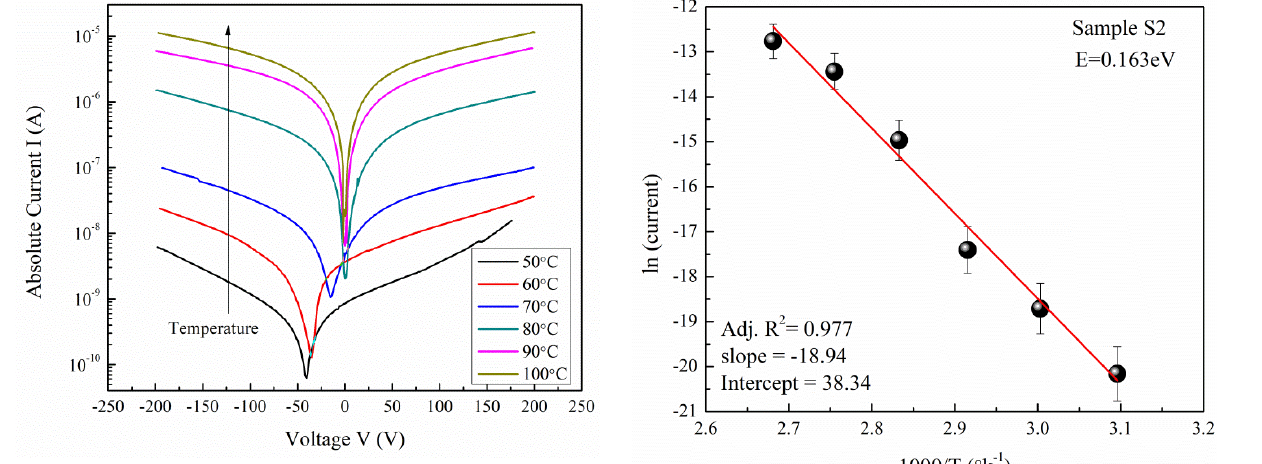
erties [40–43]. This butterfly shape is produced due to the presence of delay or lag between the applied driving pa- rameter and sample response. The activation energy for the nanocomposite sample was predicted by drawing the relation between ln(I) and 1000/T at a constant voltage value. In the present work, we selected 50V and the Arrhenius relation represented in Figure 7. The calculated activation energy was found to be 0.163eV for the nanocomposite, which is less than the one that corresponds to pure PVC (about